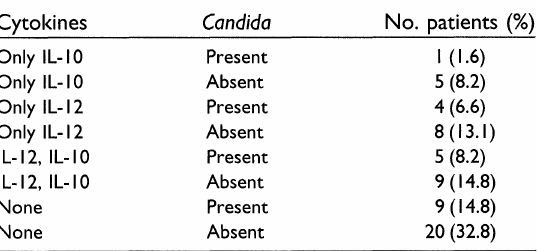
TABLE 3. Detection of IL-10, IL-12, and C. albicans in vaginal specimens from women during an episode of recurrent